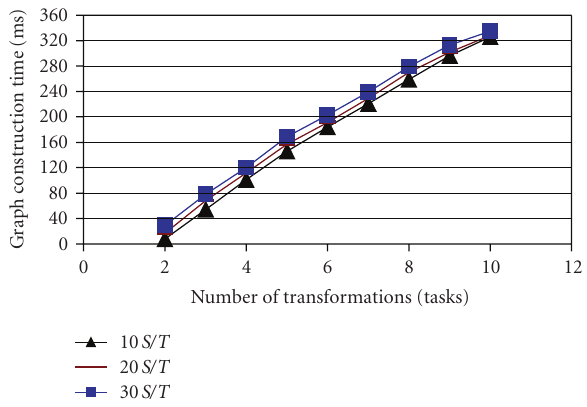
Figure 7: Graph construction